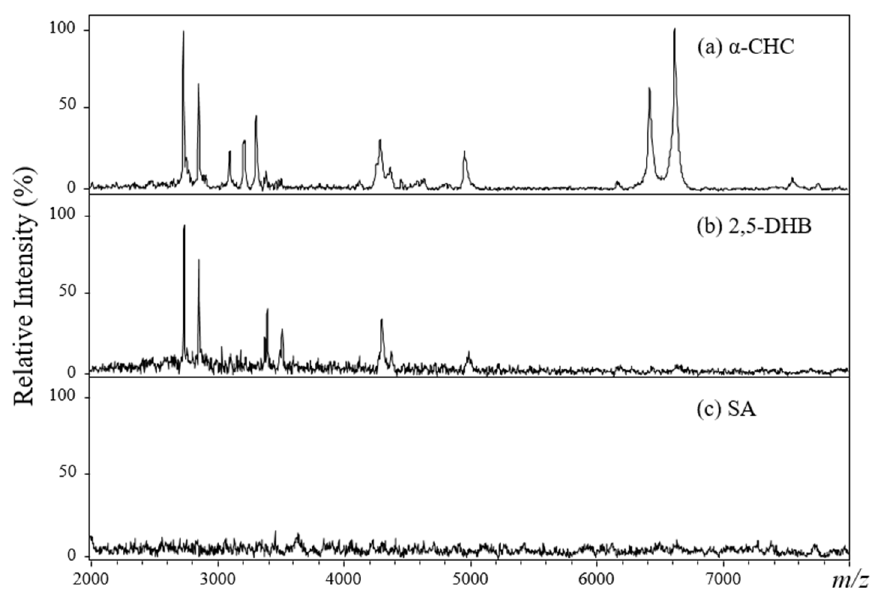
Figure 3. ( a – c ) Positive-ion MALDI mass spectra for 25% TFA-hydrolyzed plasma samples from a healthy control using different matrices (V sample :V matrix = 1:1).